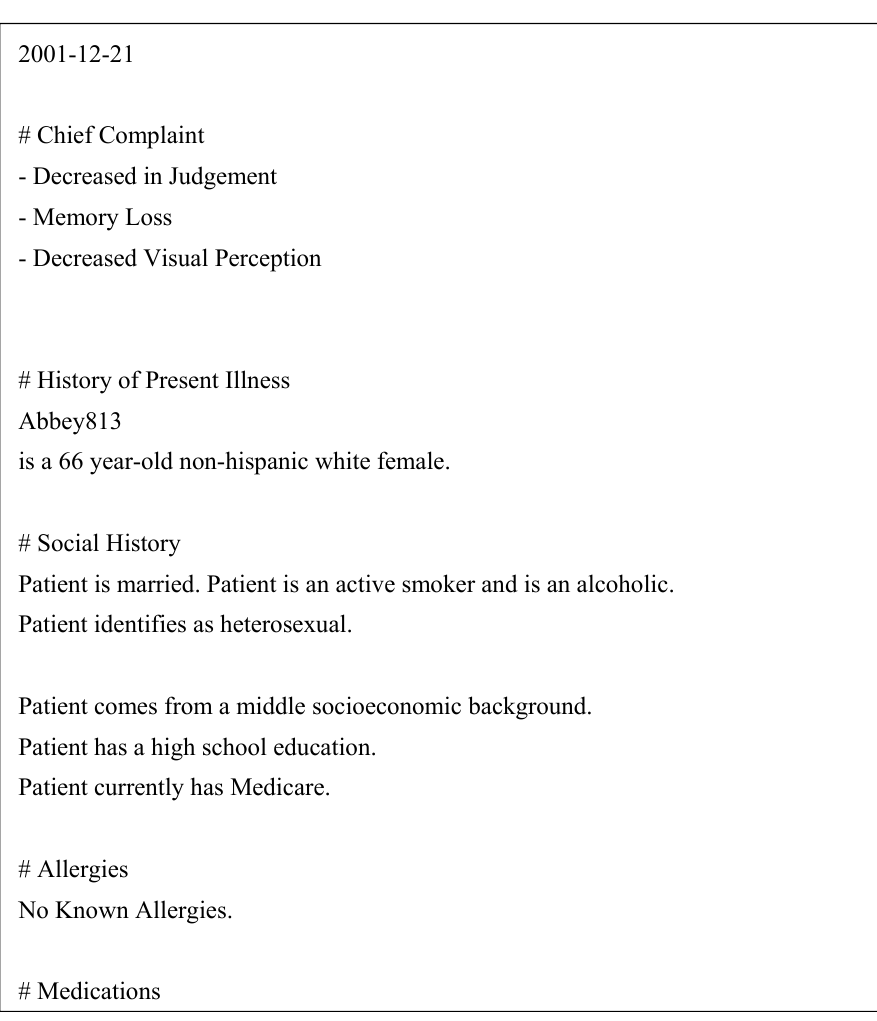
Figure A9. Clinical note for a synthetic patient that received an MRI, which found a micro-hemorrhage of the brain.